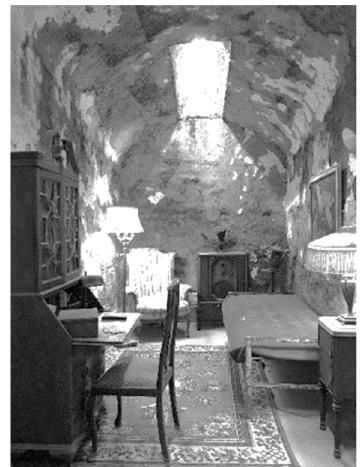
Figure 14. A view of Al Capone’s cell at the Eastern Penitentiary Museum.